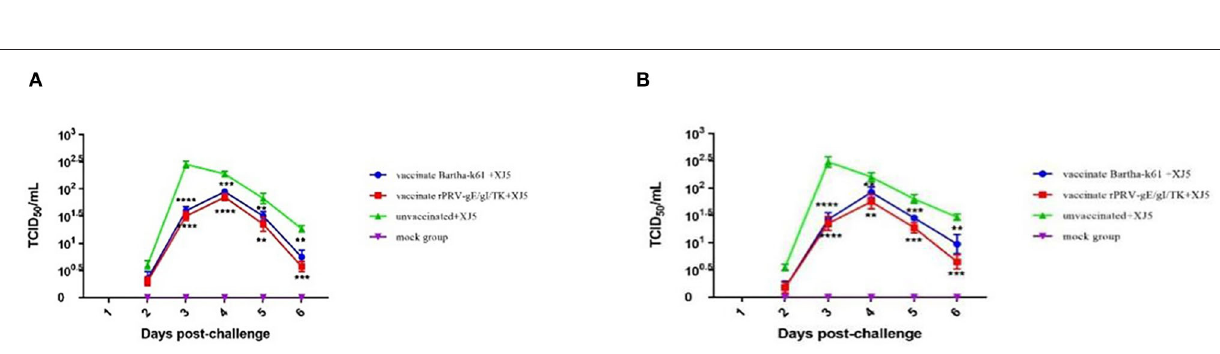
FIGURE 4 | Histopathological findings in vPRV/XJ-5 strain-challenged pigs; (A–D) : Bartha-K61 vaccinated/challenged pigs; (E–H) : rPRV/XJ5-gI − /gE − /TK − prototype vaccine immunized/challenged pigs; (I–L) : Challenge-only pigs; (M–P) : Mock pigs; (A,E,I,M) : Brain; (B,F,J,N) : Tonsil; (C,G,K,O) : Lung; (D,H,L,P) : Liver.